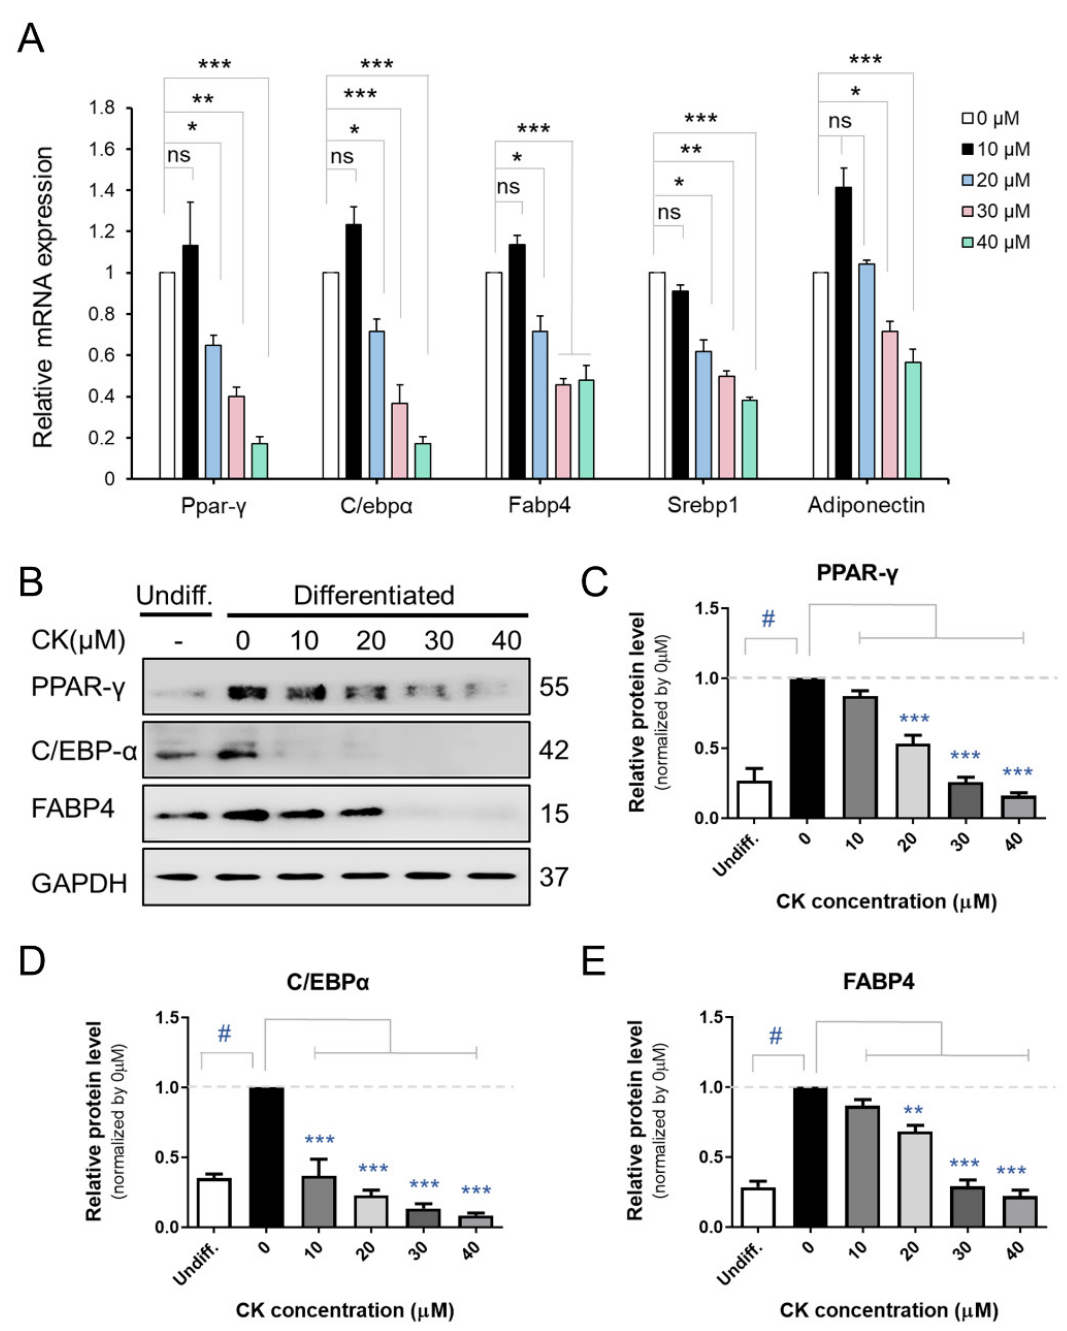
Figure 2. Effect of CK on adipogenesis in 3T3-L1 cells. ( A ) Cells were treated with various CK concentrations (0, 10, 20, 30, 40 µ M) and underwent 8 days of differentiation. Figure ( A ) displays the mRNA expression of Ppar- γ , C/ebp α , Fabp4, Srebp1c, and Adiponectin genes in 3T3-L1 adipocytes. ( B ) Immunoblot analysis of PPAR- γ , C/EBP α , and FABP4 proteins according to CK concentration treatment during adipogenesis in 3T3-L1 cells. ( C – E ) Quantified and normalized protein levels of PPAR- γ ( C ), C/EBP α ( D ), and FABP4 ( E ), respectively. Data were represented with mean ± SD for n = 3. *: p < 0.05, **: p < 0.01, and ***: p < 0.001, significant difference between DMI group and DMI + CK treatment group; # : p < 0.001, significant difference between DMI group and undifferentiated group (Undiff.); DMI + CK 0 μ M. The results were considered not significant (ns) when p > 0.05.